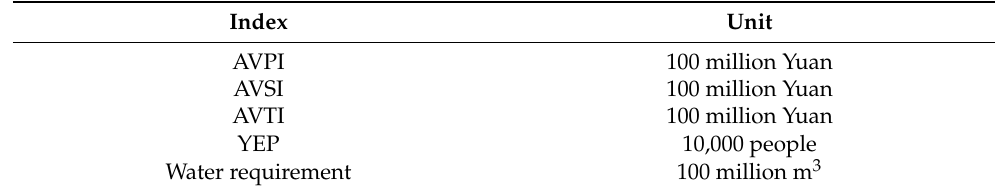
Table 1. Social and economic index.